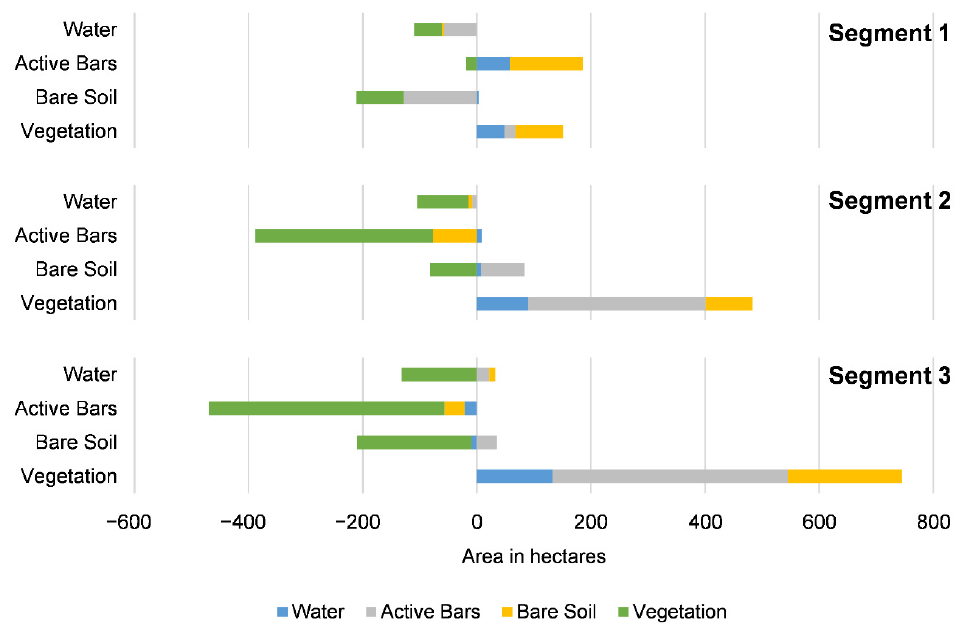
Figure 6. Contributions to net change per land cover 1989–2018. The vegetation cover stood out as the most dynamic in the analysis period. Figure 7 shows the spatial distribution of these variations. Between 1989 and 2018, 1686 ha were colonized, 556 ha remained plant-covered, and only 297 ha were lost. At the segment level, 54% of the gains came from segment 3, 32% from segment 2, and only 14% from segment 1. In terms of losses, 51% came from segment 3, 31% from segment 1, and 18% from seg- ment 2. It is important to note that a large portion of the vegetation loss identified by the 2014–2018 polygons was directly related to gravel mining, which was possible due to the low discharges that offered ideal work conditions in the active channel.